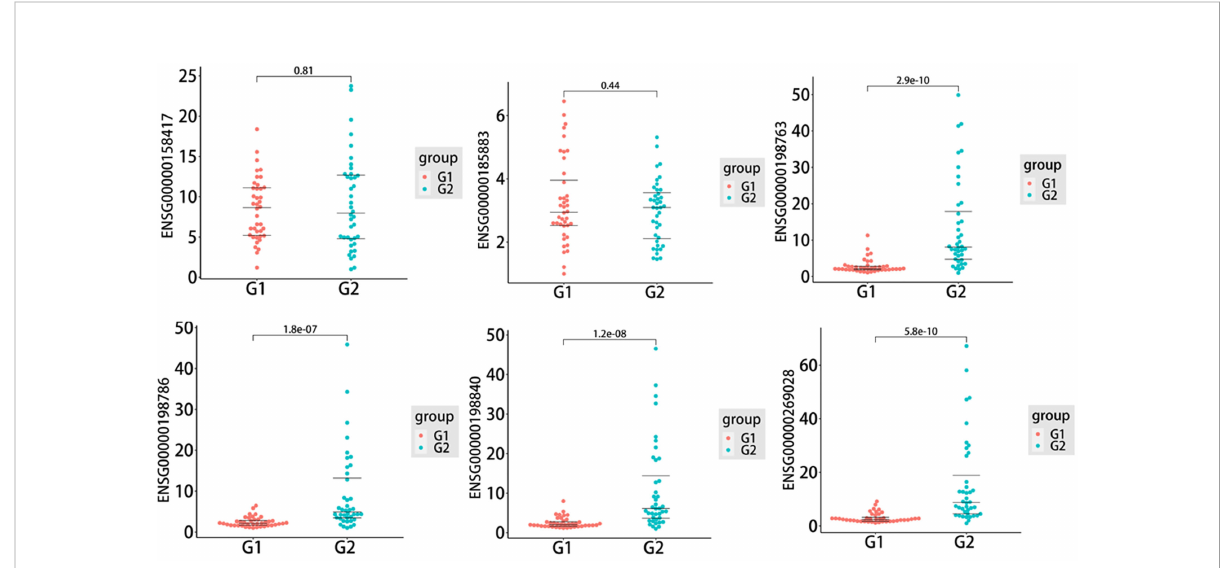
FIGURE 4 The quantitative real-time PCR (qRT − PCR) results of six selected differentially expressed mRNAs (DEMs) in the type 1 diabetes mellitus (T1DM) and control groups (T1DM N=40; controls N=40). Statistically signi fi cant differences ( P value < 0.05) were calculated by unpaired t test. The three lines in each fi gure represent the median and interquartile spacing. G1: control group; G2: case